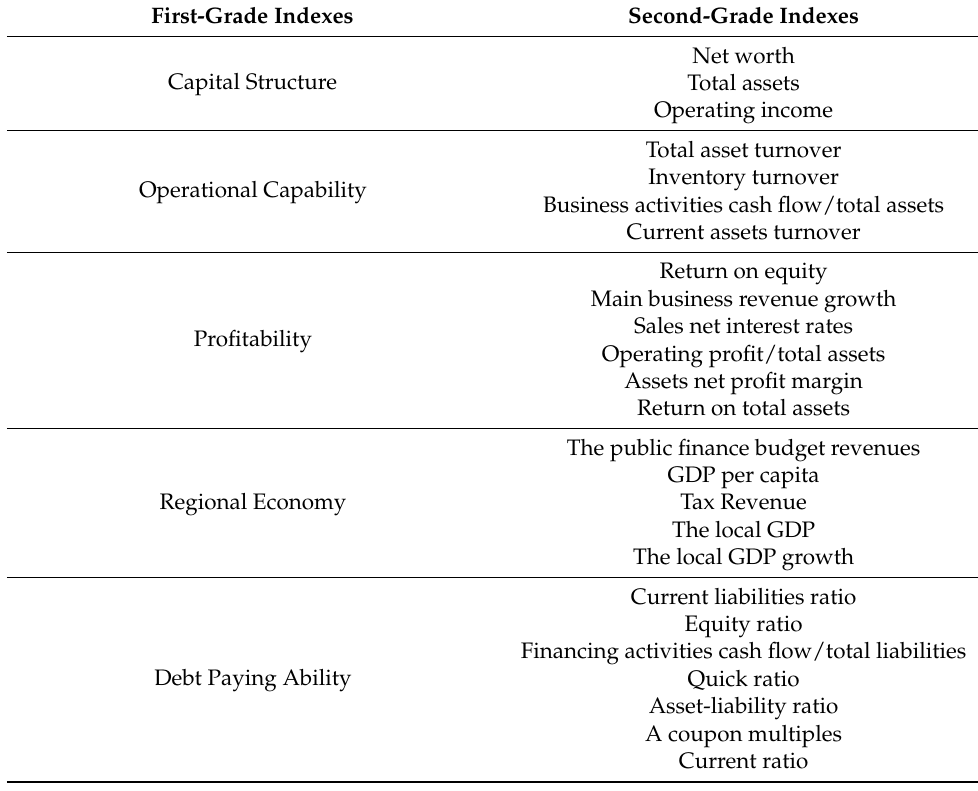
Table 1. City investment company characteristic index